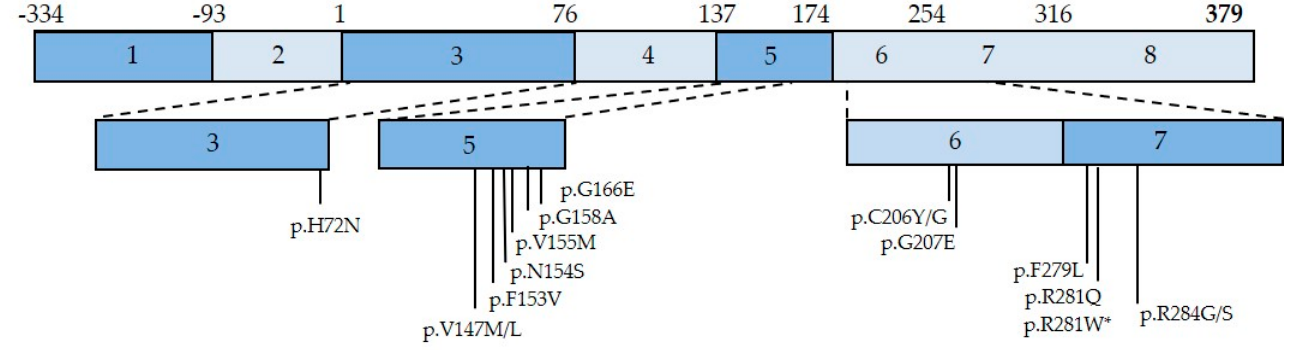
Figure 2. Schematic Representation of STING Protein Encoded by STING1 Gene and Localization of Disease-Causing Mutations. * indicates homozygous mutations.